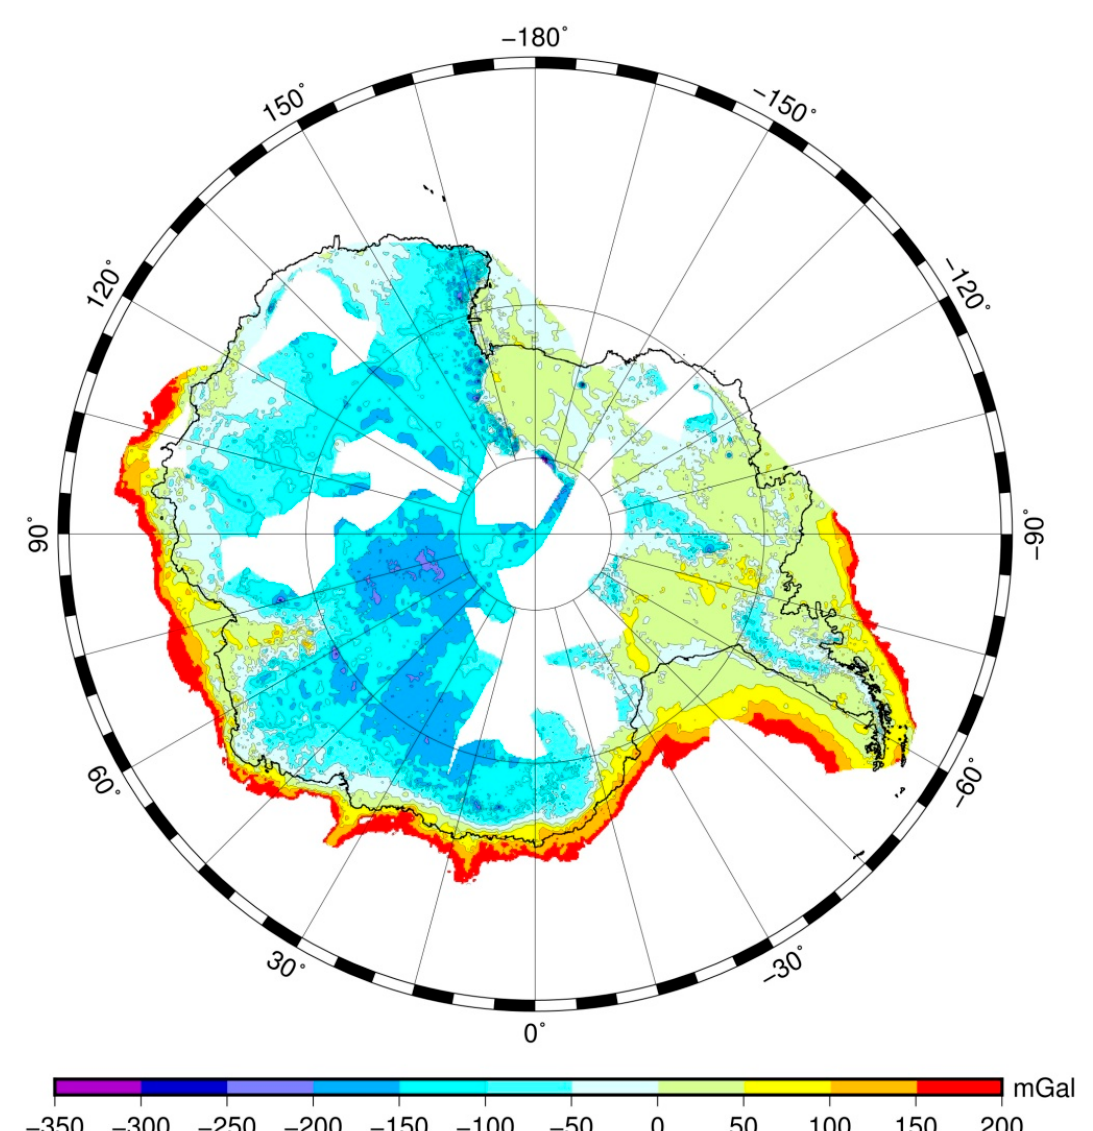
Figure 11. Gridded data of BG anomalies (mGal) at continental scale (contour interval at 50 mGal). The spatial distribution of absolute vertical velocities may relate to the activity of the known regional NW-SE faults [9,15,40]. The comparison of such distribution with the models does not substantially change this interpretation [14], except for the high uplift rates in the Antarctic